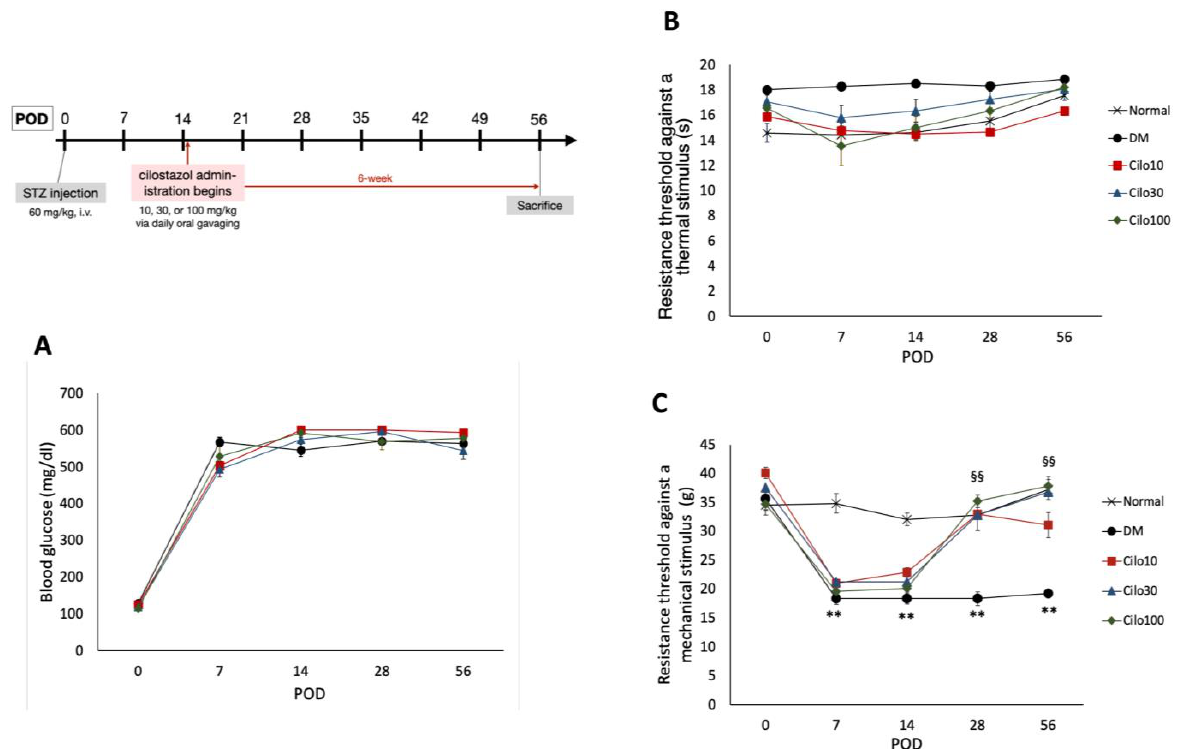
Figure 1. Experimental timetable and effects of cilostazol treatments on ( A ) blood glucose levels and hind paw withdrawal thresholds against ( B ) thermal and ( C ) mechanical stimuli. Scatter points represent SEM; error bars represent SE. ** Indicates significant differences at p < 0.001 compared to baseline values, and §§ at p < 0.001 compared to the corresponding DM value, standard single factor analysis of variance (ANOVA). POD, post-operation day; Cilo10, 10 mg/kg cilostazol; Cilo30, 30 mg/kg cilostazol; Cilo100, 100 mg/kg cilostazol.